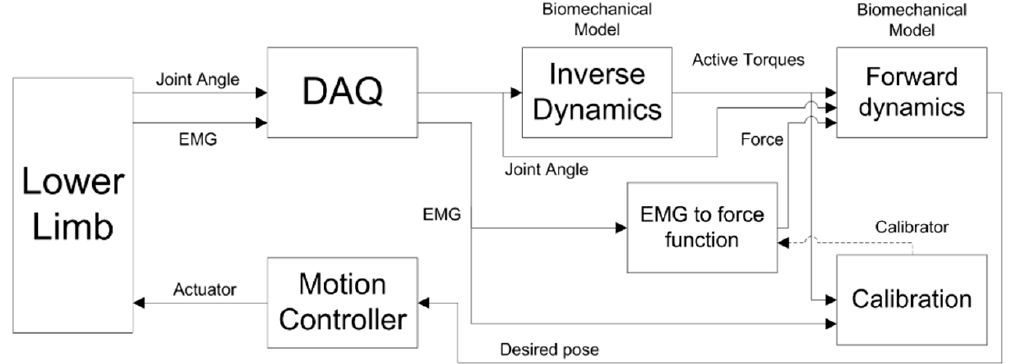
Figure 11. EMG-force model for the desired position estimation [46]. A biomechanical model was used for the inverse and forward dynamics. Calibration was done on the EMG to force the function.